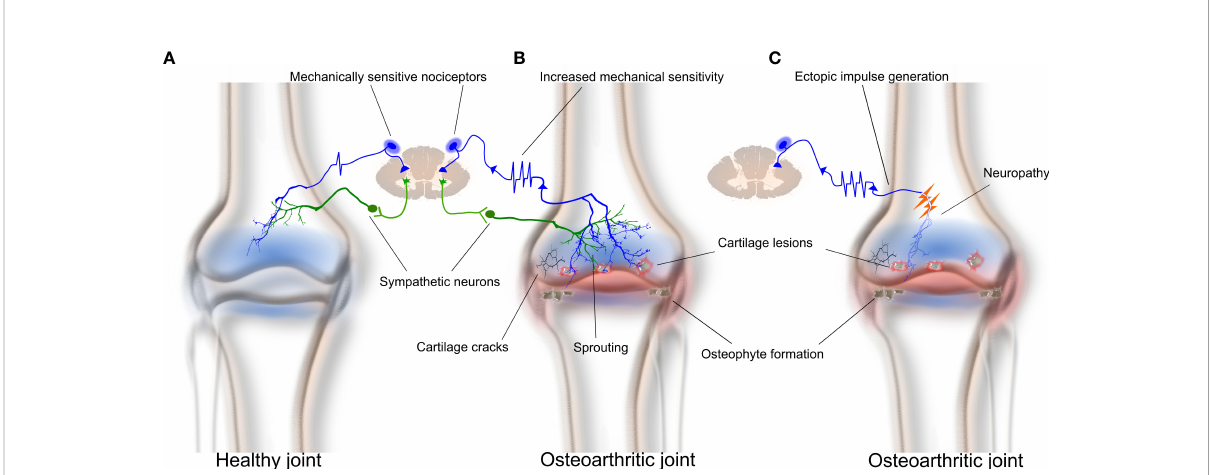
FIGURE 1 The subchondral bone contributes to osteoarthritis pain through mechanical sensitization, sprouting, and/or neuropathy of bone nociceptors. Osteoarthritis results in joint in fl ammation, reduced synovial space, breakdown of cartilage and cartilage lesions, osteophyte formation, and subchondral bone lesions and sclerosis. (A) A healthy bone with typical sympathetic and nociceptor innervation. (B) Subchondral bone remodeling in advanced osteoarthritis can result in increased neuronal sprouting of bone nociceptors and sympathetic neurons within bone. Sprouting sensitizes peripheral sensory neurons and makes them hyperexcitable. (C) Neuropathy of bone nociceptors may also contribute to osteoarthritis pain through generating ectopic spontaneous